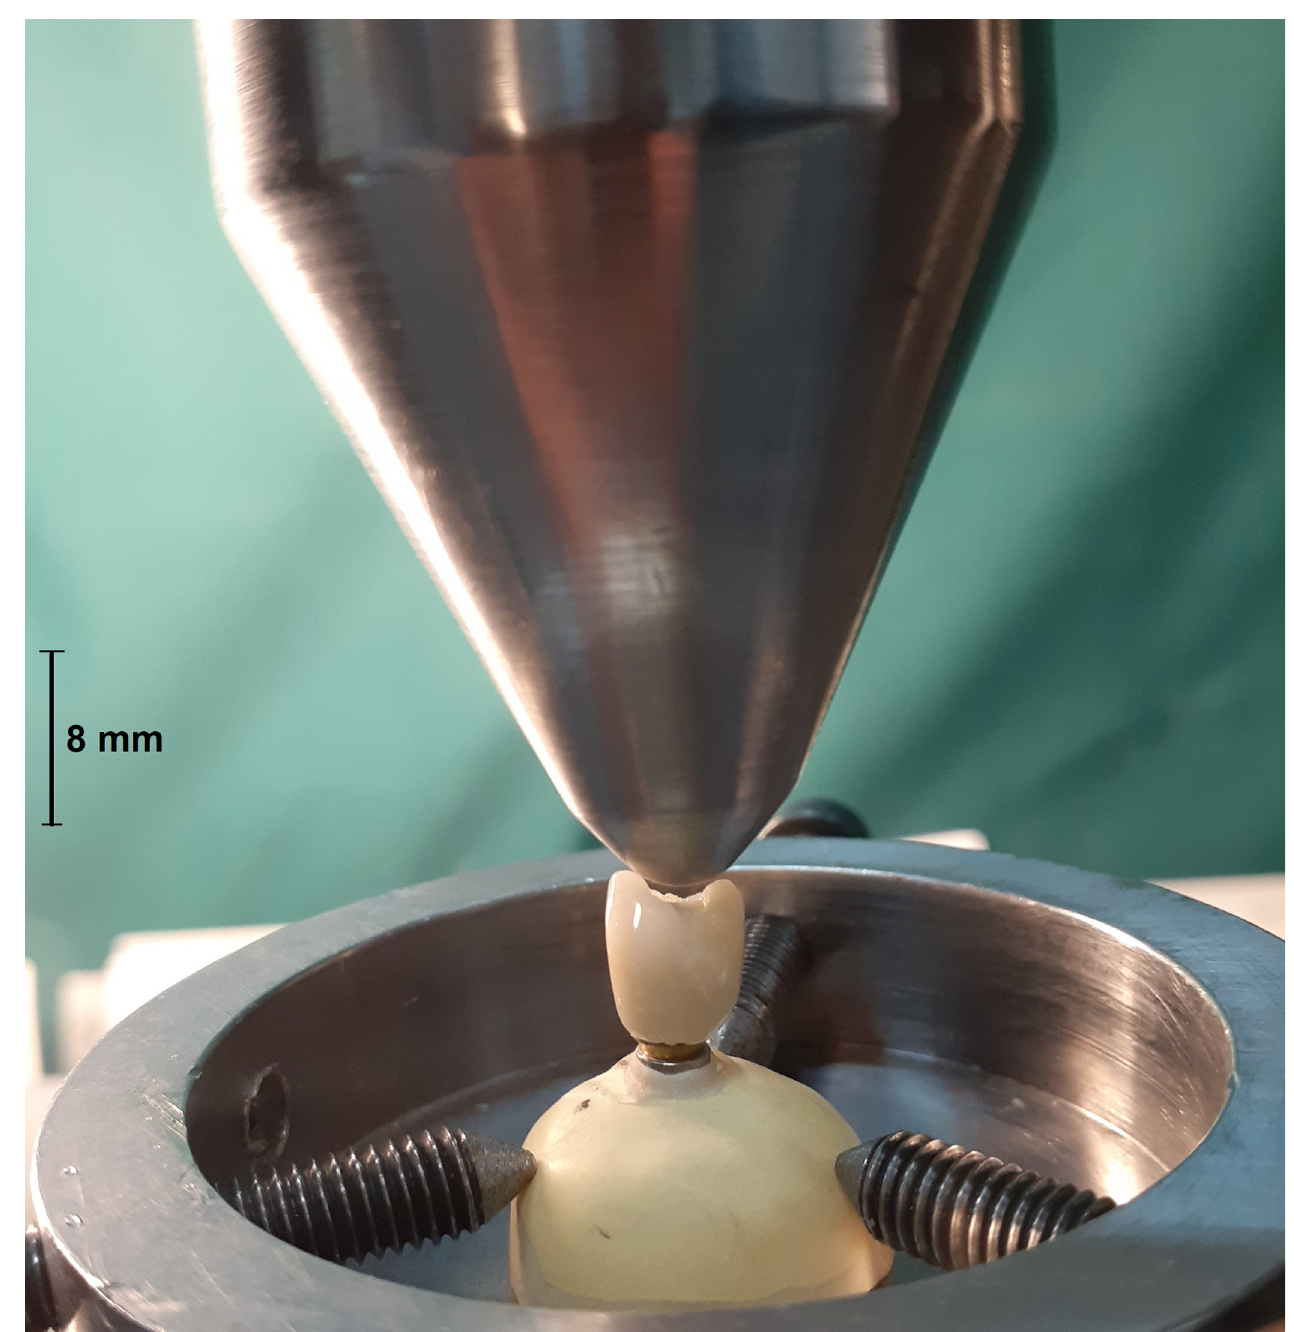
Fig 3. A specimen being tested in the universal testing machine. the PVZ group. Wax patterns and abutments were then scanned with the CAD software (Fas- tDesign, Glidewell, United States) and milled with the CAM machine from monolithic zirco- nia blocks (Dental Direkt, Germany) ( Fig 2C ). Wax plugs were used to preserve the screws from cement so they can be later accessed and tightened. The restorations were cemented onto the abutments by using a dual-cure resin